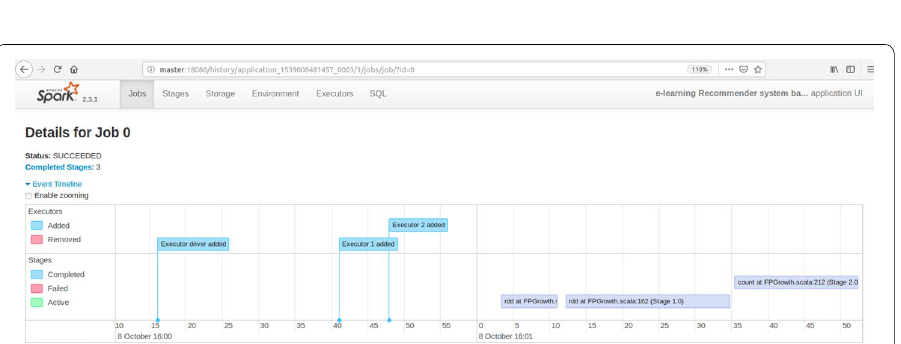
Fig. 11 Timeline view of Spark events: It shows the events of one job. Spark gives also the possibility to visualize the timeline view across all jobs or within one